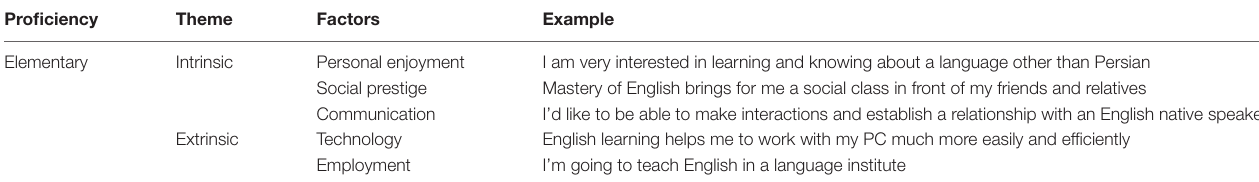
TABLE 5 | Motivational factors influencing elementary EFL learners. Proficiency Theme